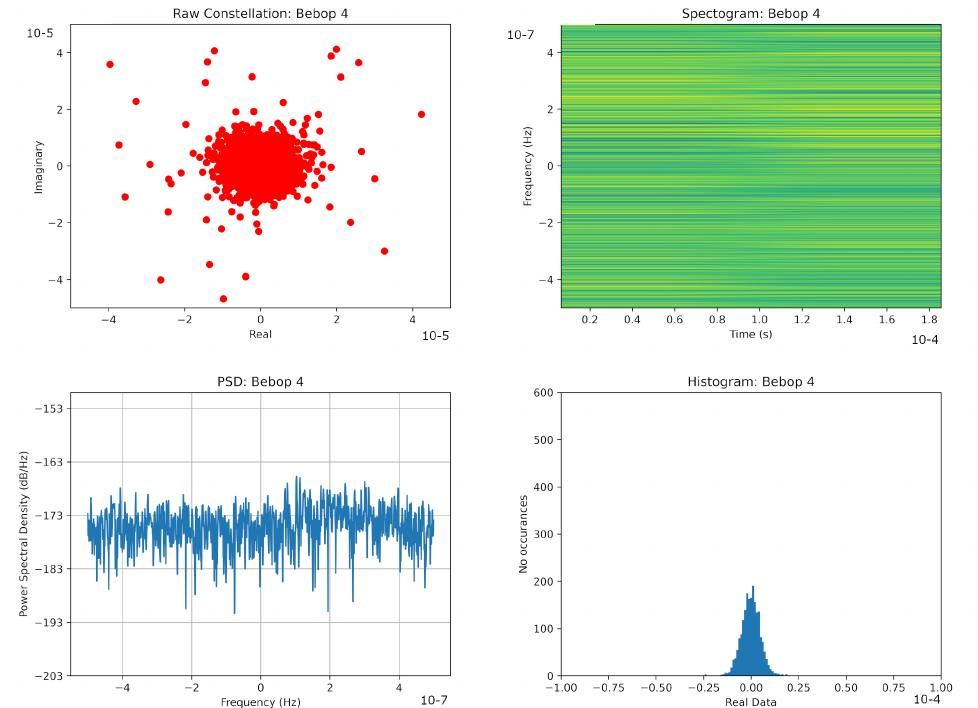
Figure 6. Bebop Mode 3—flying without video.